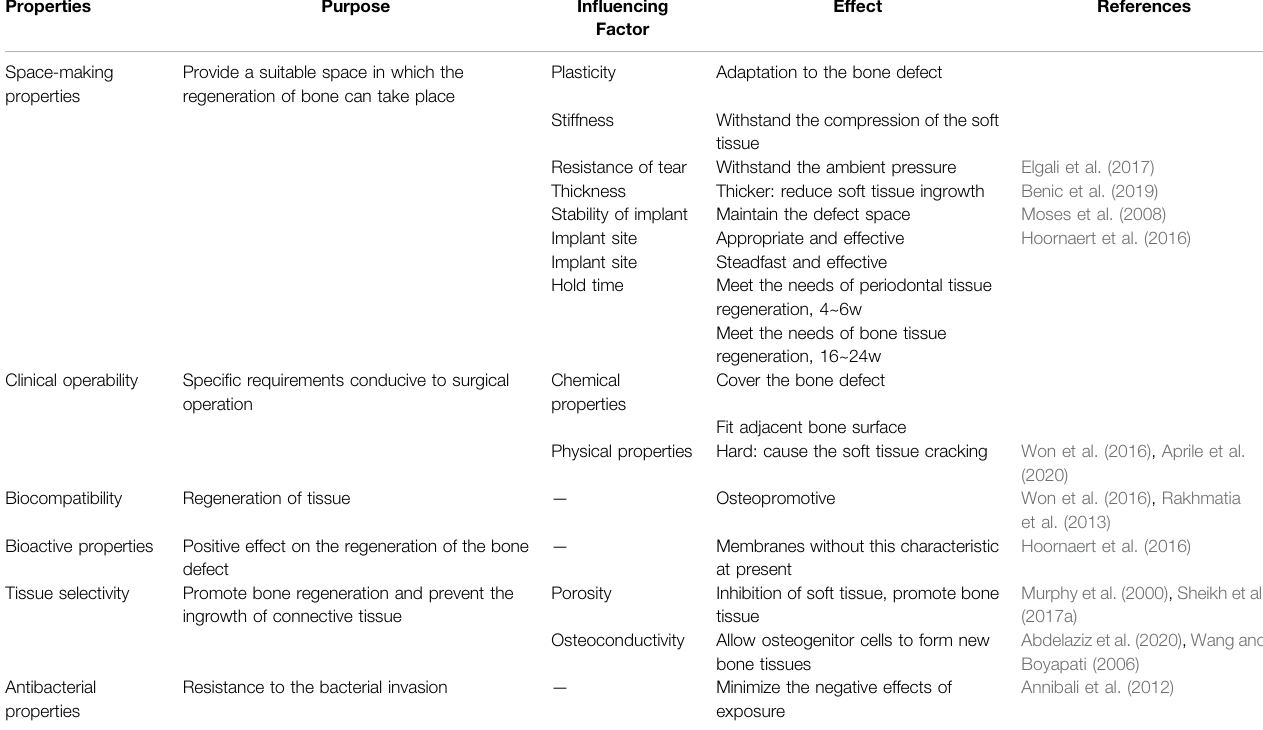
TABLE 1 | Properties of ideal barrier